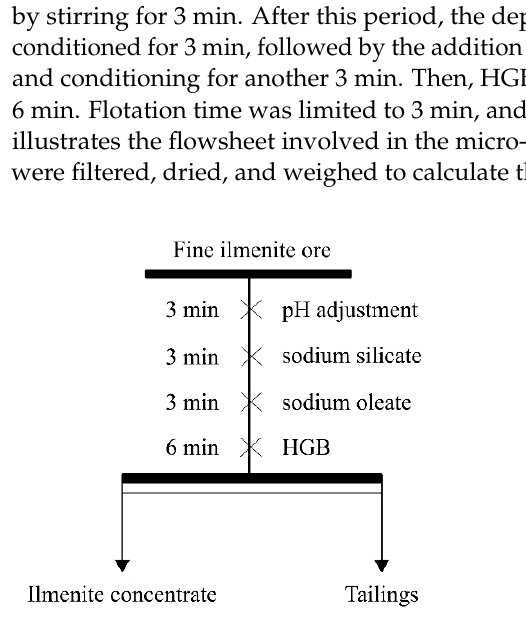
Figure 5. Effect of HGB dosage on fine ilmenite and fine titanaugite recoveries (the mineral size distributions of 0–19 µm, 4.0 × 10 −4 mol·L −1 sodium oleate).